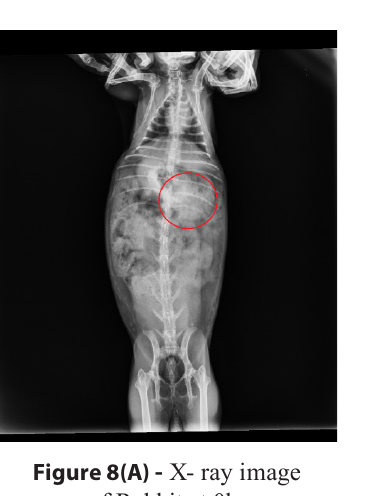
Figure 8(A) - X- ray image of Rabbit at 0h.